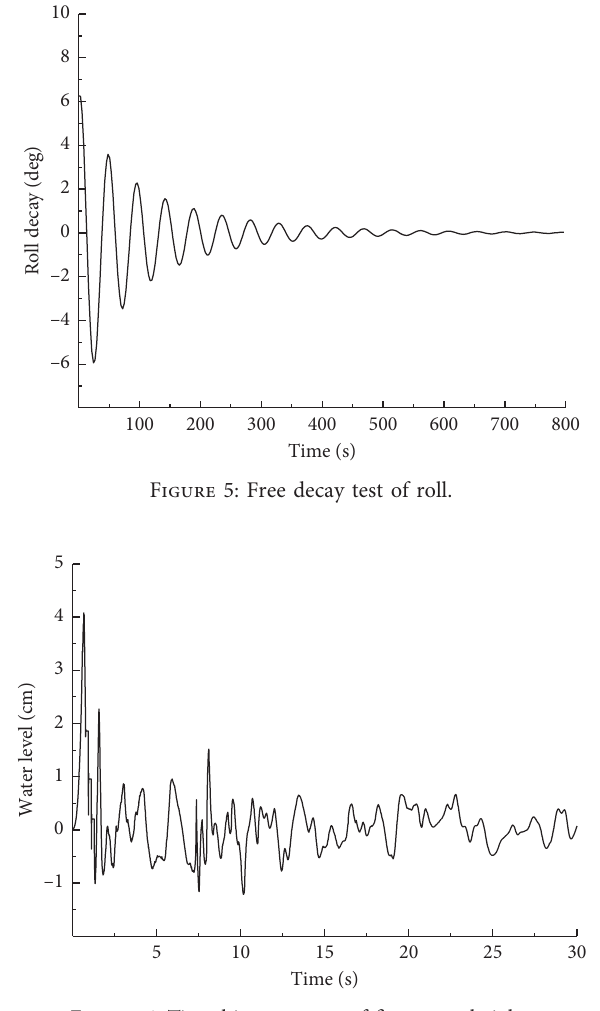
Figure 6: Time history curve of first wave Table 2: Initial wave height and period statistics.